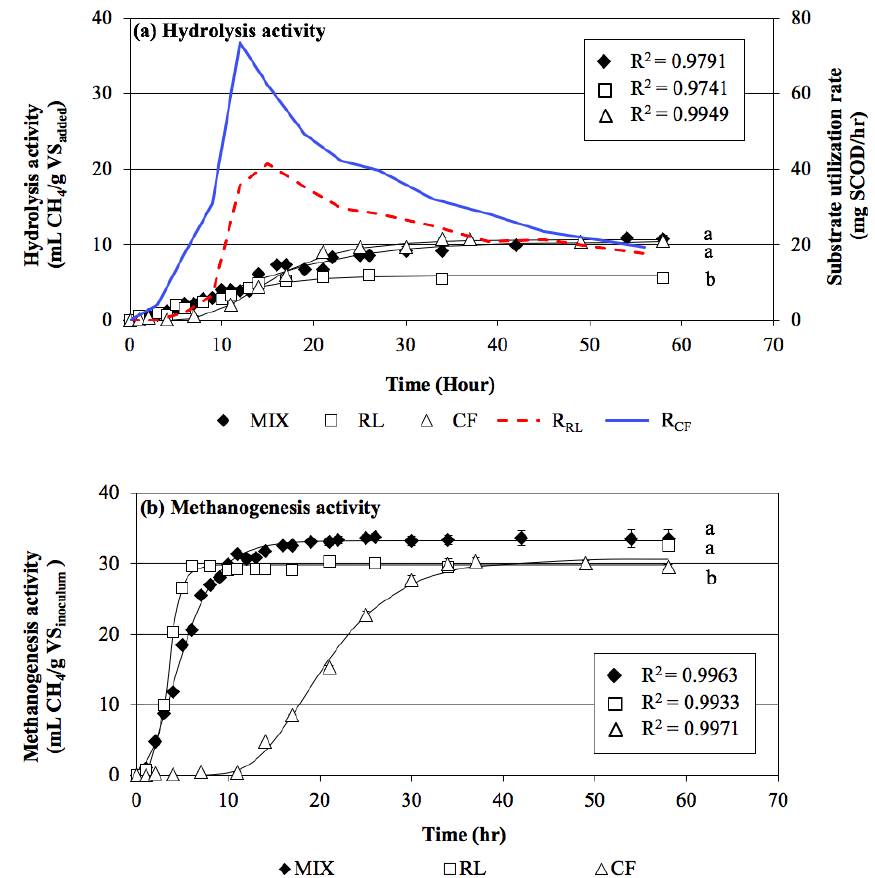
Figure 1. Anaerobic activity of different inocula; ( a ) hydrolysis activity, ( b ) methanogenesis activity (symbols = observed data, lines = predicted data by Equation (1)). Cellulose depletion in terms of substrate utilization rates of rubber latex factory (RL) and cattle farm (CF) sludges (R RL and R CF ) over time are plotted to support hydrolysis activity data.